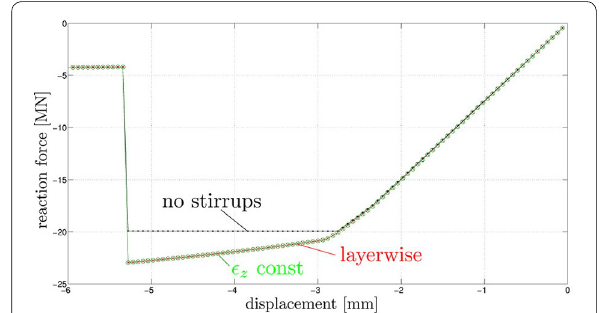
Fig. 6 Reaction force vs. displacement curves of the column compression with constant concrete ultimate strain ǫ c u = 0.0053